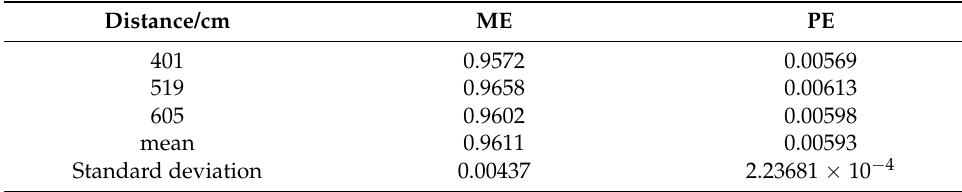
Figure 5. Light source system ( Left ), ME amplitudes ( a ) and phase errors ( b ) retrieved from measurements ( right ). Table 3. ME amplitudes and phase errors (12 September 2018).